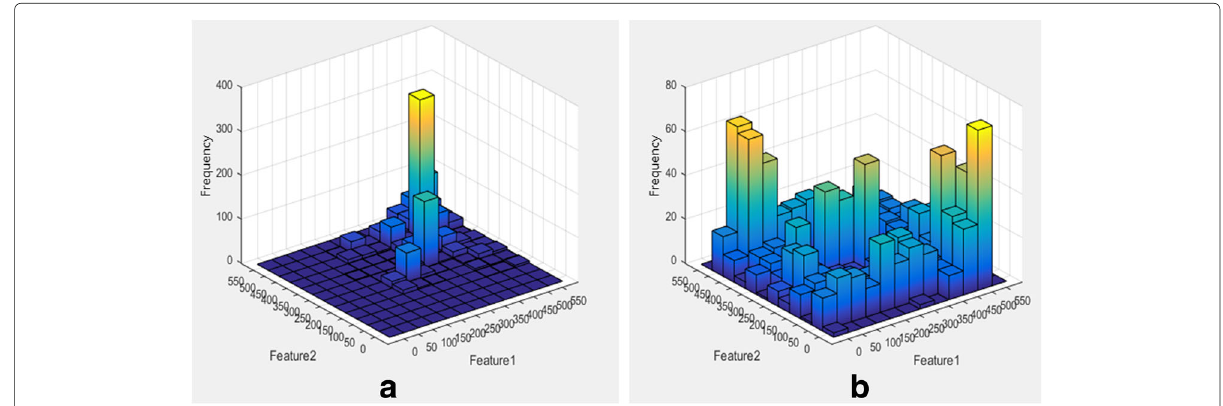
Fig. 3 Data distribution. a Positive data (face). b Negative data